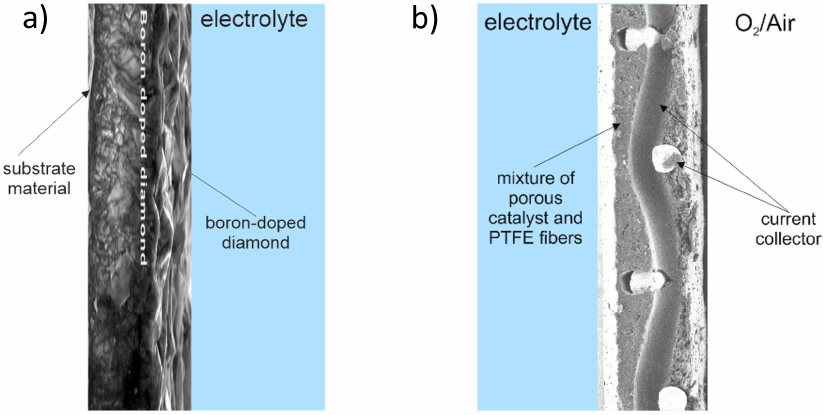
Figure 1. Scanning electron microscope images of a ( a ) boron-doped diamond anode and ( b ) a carbon-based H 2 O 2 -producing gas diffusion electrode on a Ni carrier.